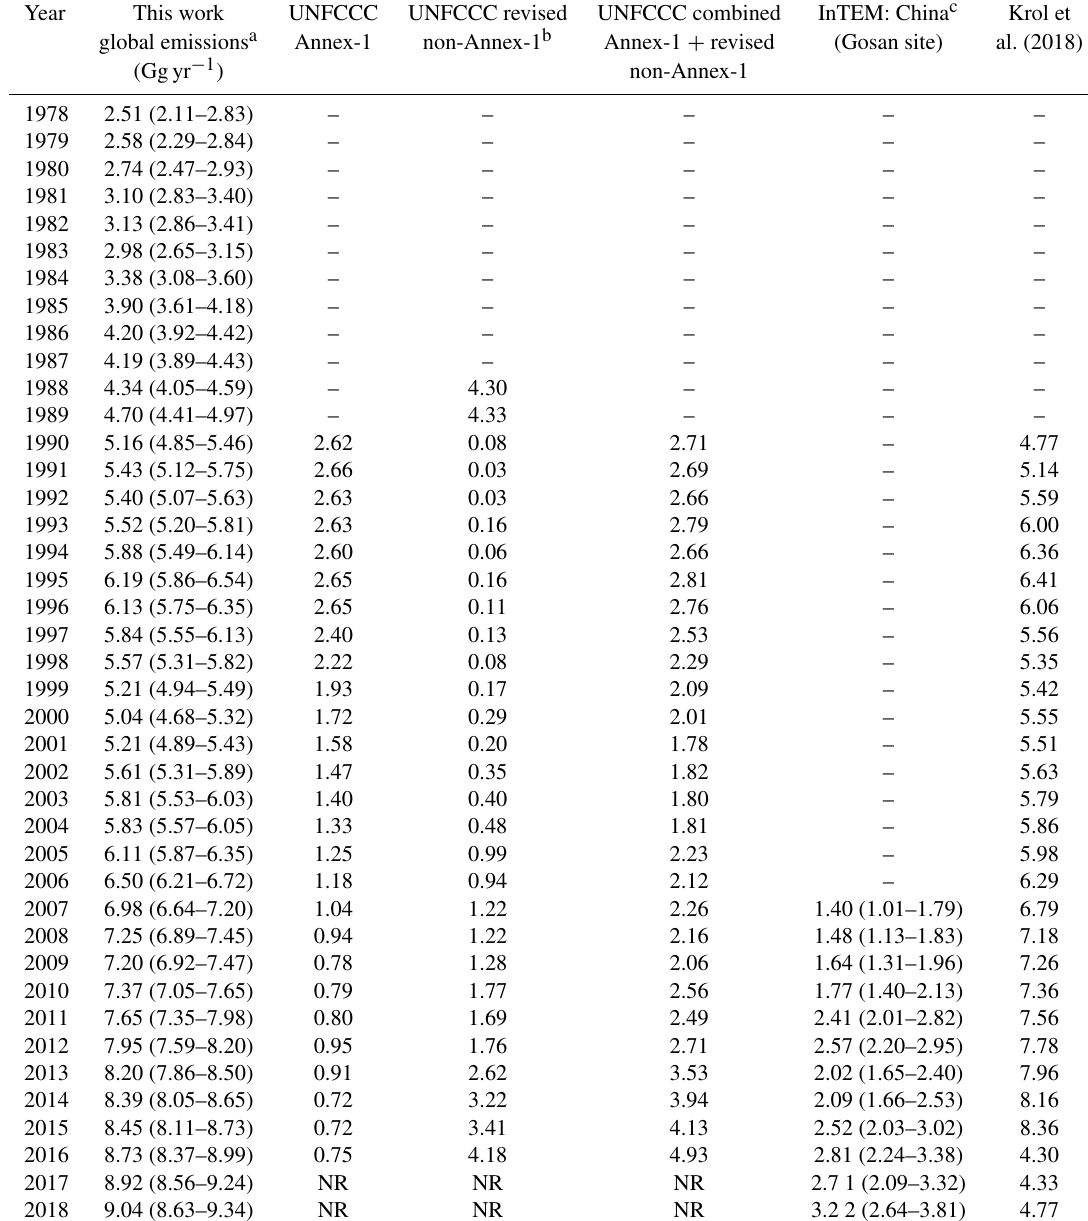
Note: uncertainties shown in parenthesis as 16th percentile and 84th percentile. NR represents “not reported”. a Global emissions are mid-year data. b Revised non-Annex-1 includes interpolated values for missing years. c Chinese SF emissions by